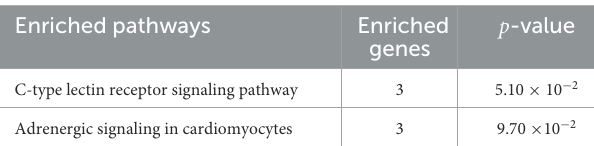
TABLE 4 KEGG enrichment analyses of mRNA targeted by miRNA binding with